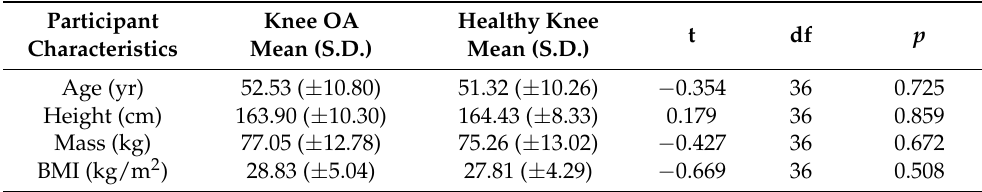
Table 1. Participant